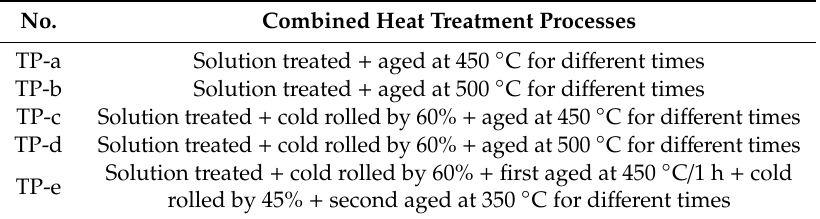
Table 2. Combined heat treatments for the NS-4